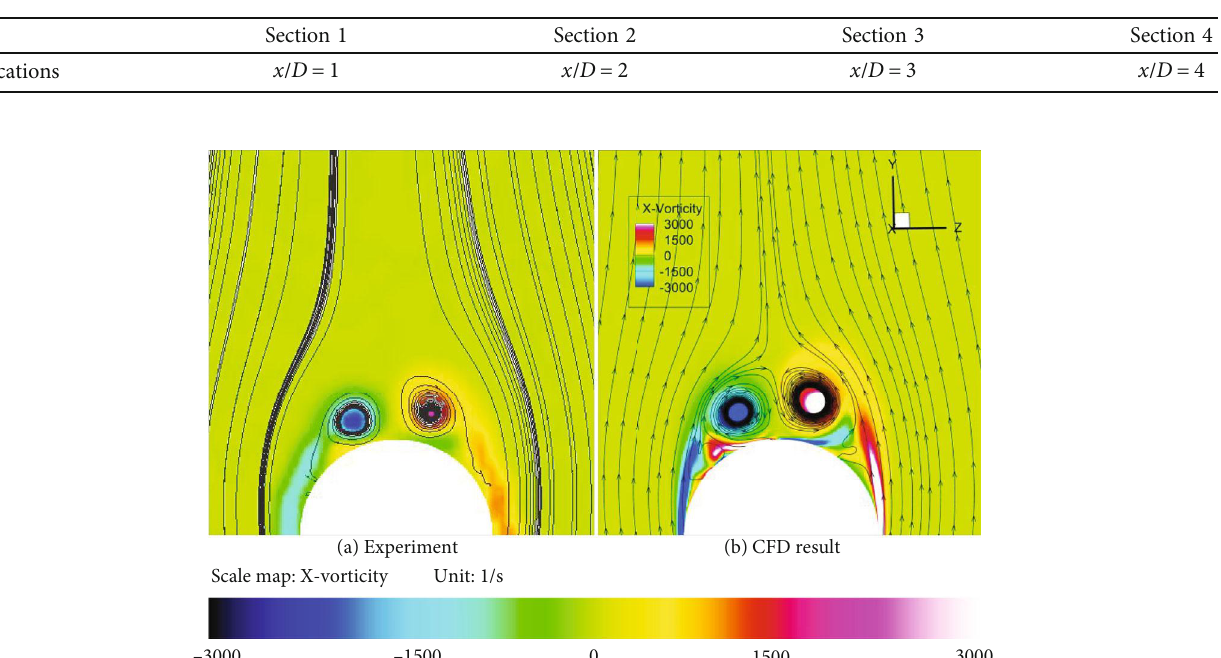
Table 7: The location of the four